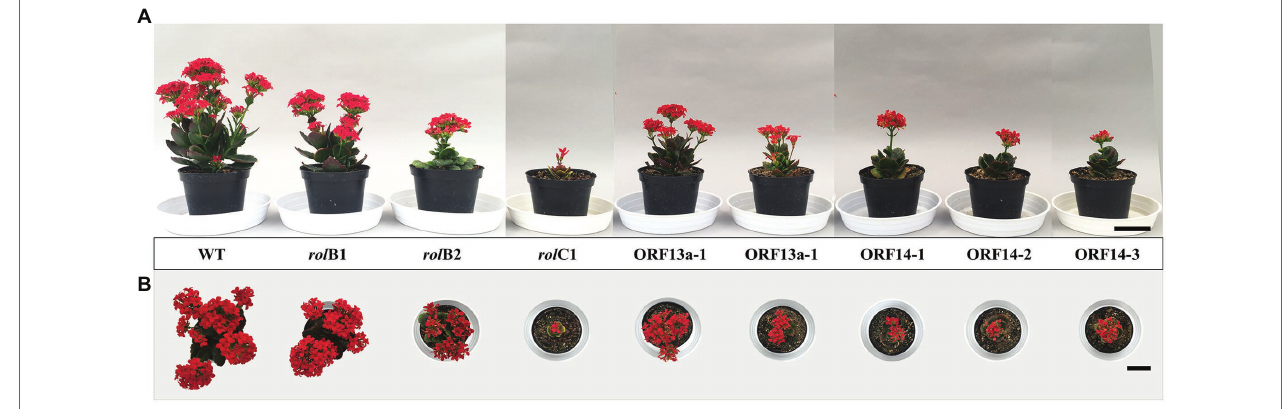
FIGURE 2 | Phenotype of transgenic lines. (A) Frontal and (B) top view of transgenic lines and wild type (WT) K. blossfeldiana ‘Molly’ plants at 4 months after the flower induction, i.e. short day treatment, was initiated. Bar = 5